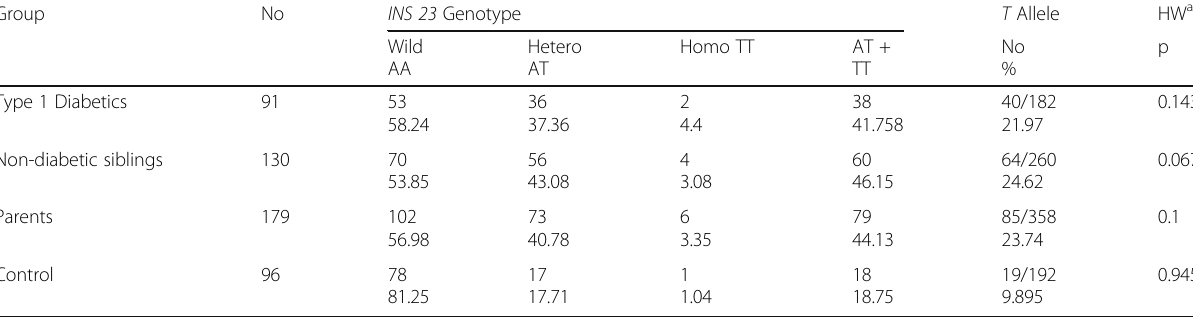
Table 1 Genotype and allele frequency of INS -23 A>T in type 1 diabetes mellitus families Group